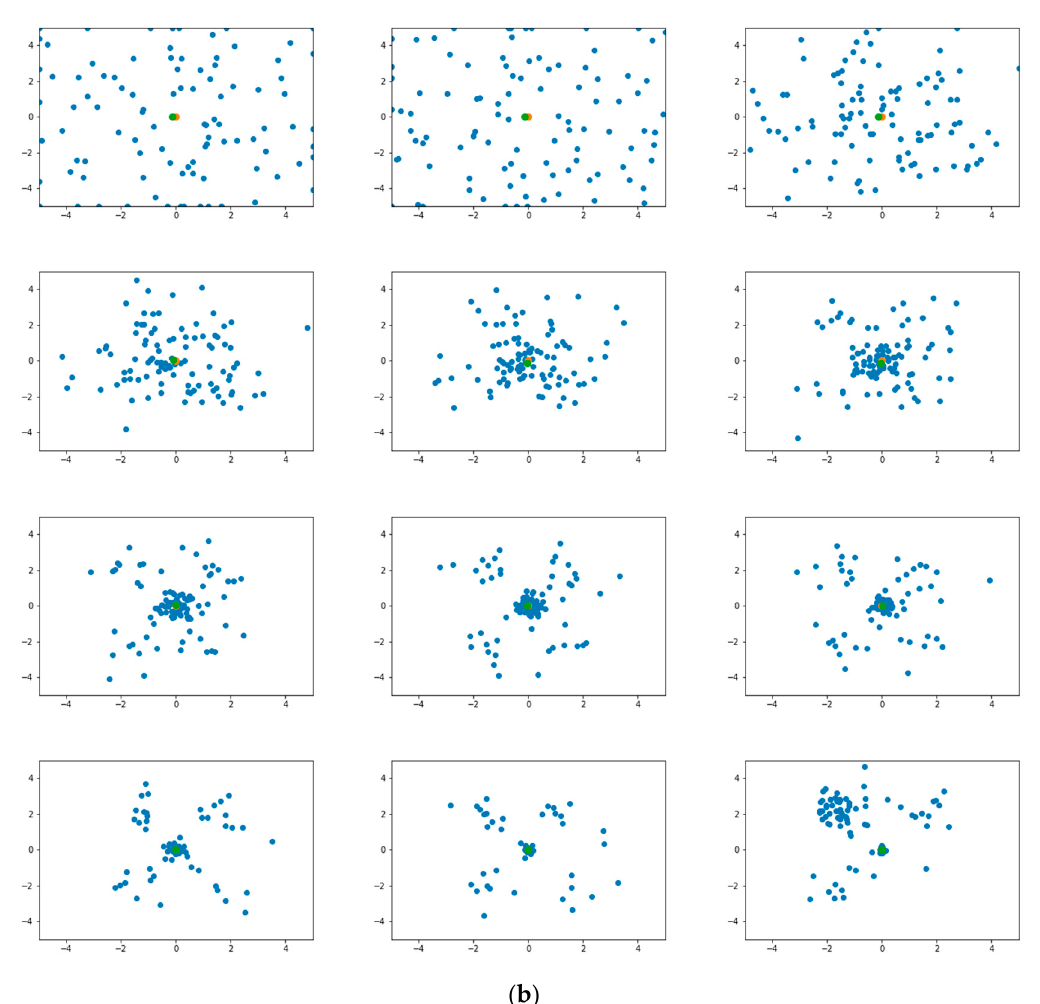
Figure 2. ( a ) Function (16). ( b ) Function (17). For an animated demonstration, see for example, https://en.wikipedia.org/wiki/Particle_swarm_optimization#/media/File:ParticleSwarmArrowsAnimation.gif.